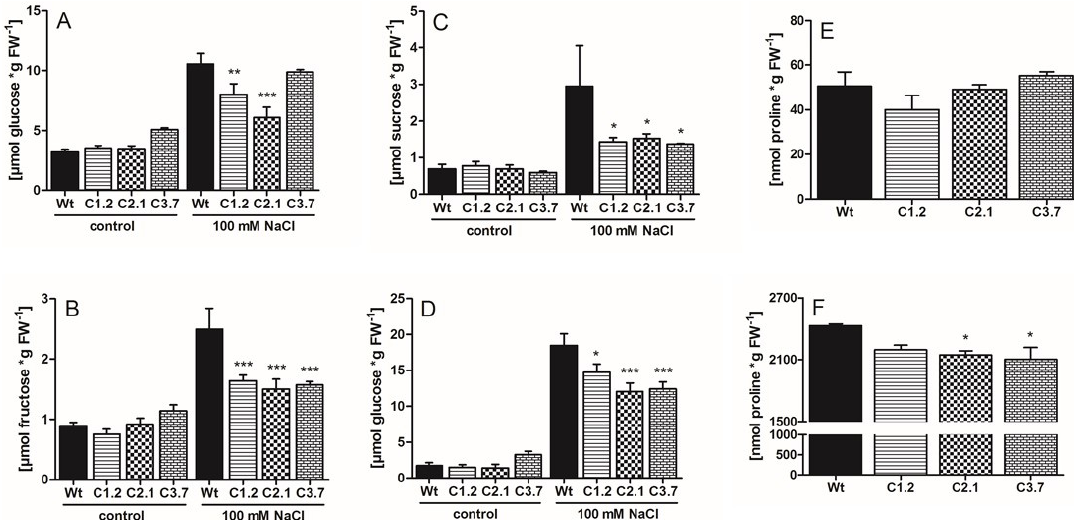
Figure 8. Metabolite accumulation in Arabidopsis leaves during 72 h of salt stress. ( A ) glucose, ( B ) fructose, ( C ) sucrose, ( D ) starch (in glucose equivalents), ( E , F ) proline. Wt plants and 35S::SOS1 C-terminus overexpression lines were grown in hydroponic culture for five weeks and watered ±100 mM NaCl 72 h prior to measurement. Sugar accumulation was determined in leaves under control and under salt stress conditions, quantified by IC. Proline accumulation was quantified by HPLC. Values represent the mean of 3 biological replicates, each with 2 technical replicates. Error bars are ±SE. Data with *, **, *** are significant from Wt at p < 0.05, p < 0.01 or p < 0.001 (two-way ANOVA).